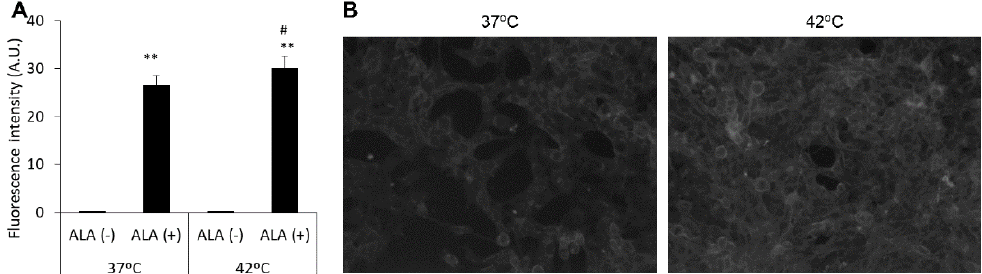
Figure 3. The fluorescence intensity of porphyrin-derived ALA. ( A ) Fluorescence intensity of por- phyrin measured by a microplate reader; ( B ) Fluorescence intensity distribution in cells observed under the fluorescence microscopy. The cells were incubated at 37 °C or 42 °C for 1 h and then at 37 °C for 24 h. After the treatments, the cells were incubated with 1 mM ALA for 6 h. Data are expressed as means ± SD ( n = 6). ** p < 0.01 vs. 37 °C ALA ( − ). # p < 0.05 vs. 37 °C ALA (+). Tukey’s post hoc test.